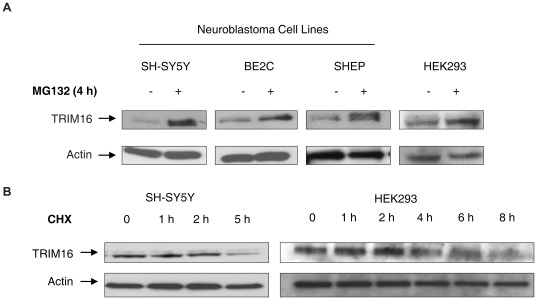
TRIM16 is an unstable protein regulated by the ubiquitin-proteasome system.(A) In vivo degradation assay was performed with cells being incubated with and without 30 µM MG132 for 4 hours. Lysates were subjected to Western blot analysis of endogenous TRIM16 antibody. (B) The liable nature of TRIM16 was further evaluated by inhibition of protein synthesis using 100 µg/ml cycloheximide. At the specified time points the cells were harvested and the protein were extracted for analysis by Western blots.